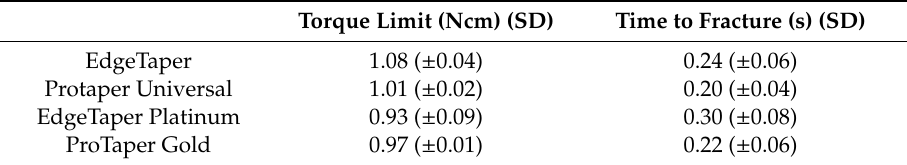
Table 2. Mean and standard deviation of torque to fracture and time to